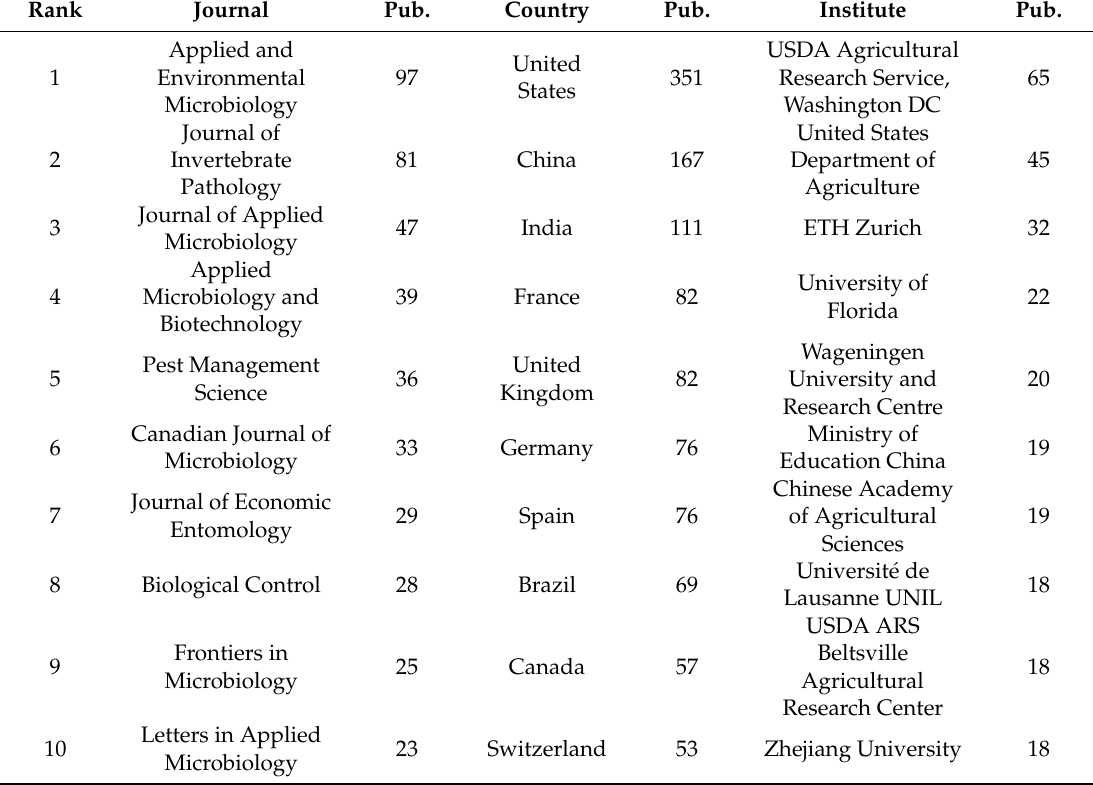
Table 1. Performance analysis: Journal, Country, and Institute for “biological pest control” and “microorganism” from 1973 to 2020 (18 September).